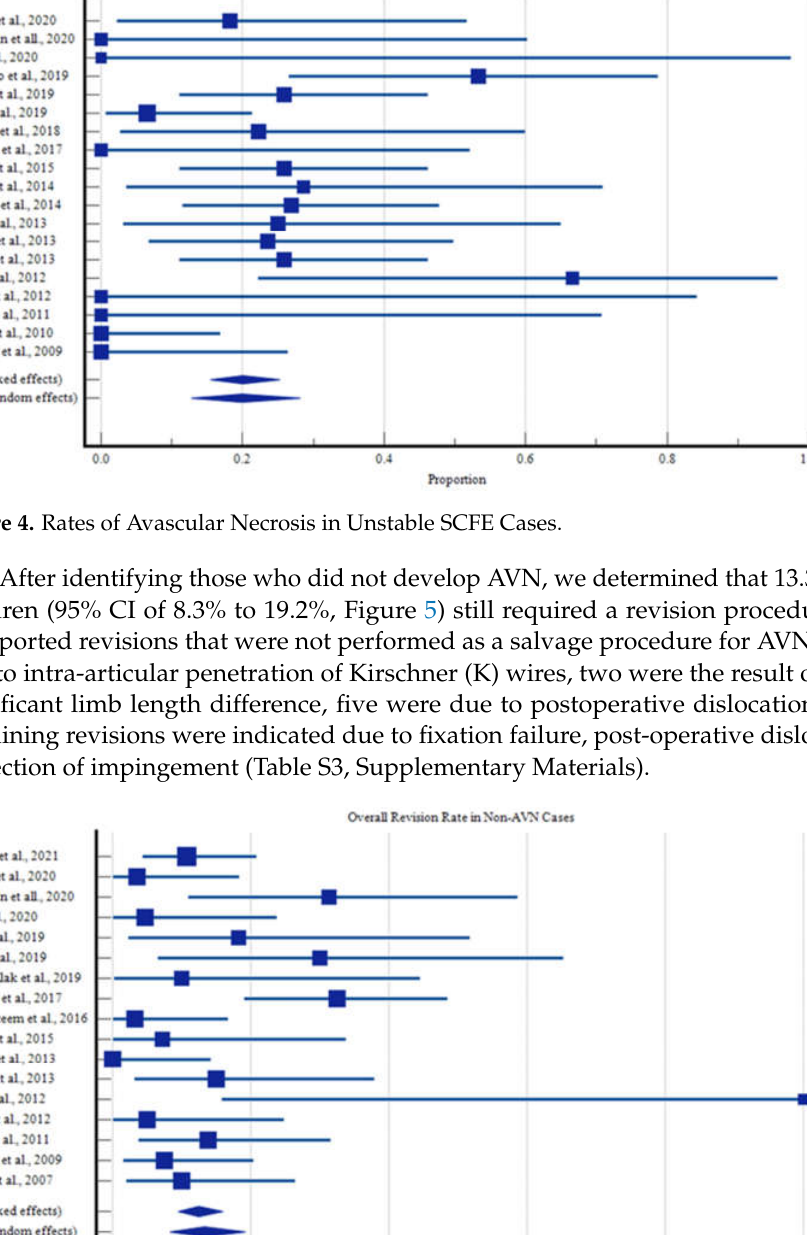
Figure 3. Rates of Avascular Necrosis in Stable SCFE Cases.